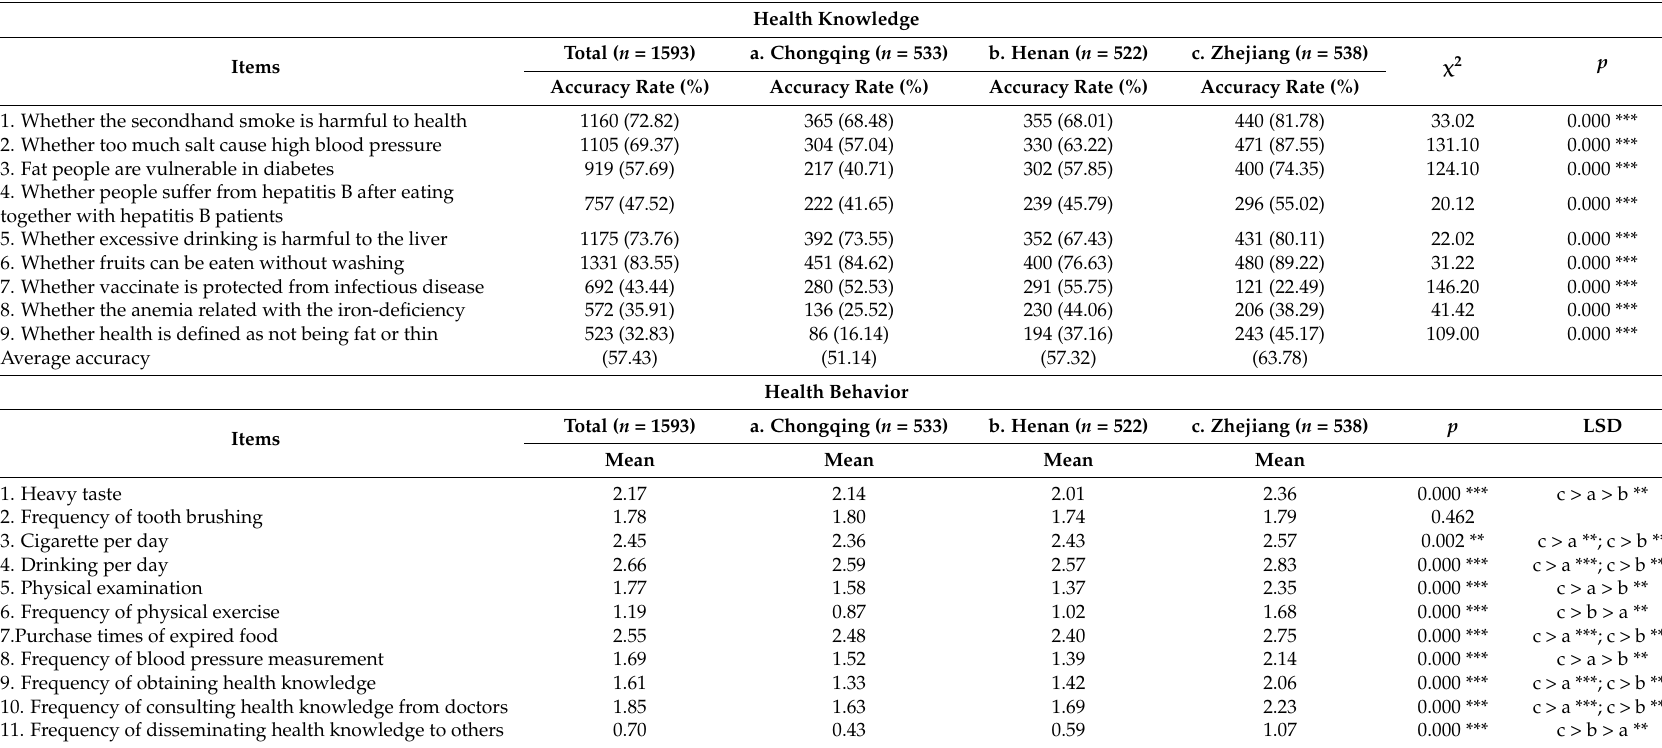
Table 3. Accuracy rate of the health knowledge and mean scores of the health behavior of the elderly in sample